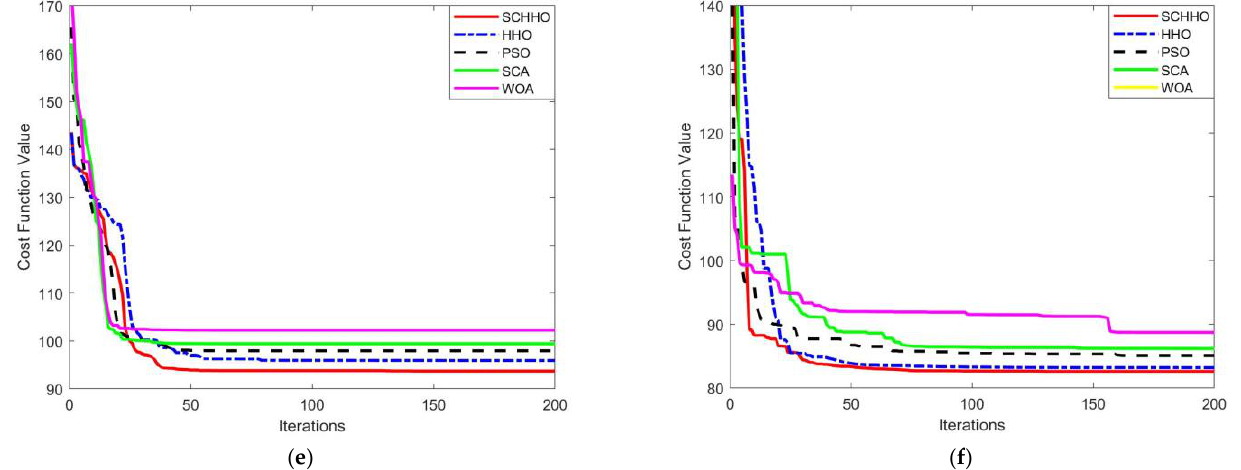
Figure A2. Convergence curves of five algorithms on six benchmark functions when n = 50. ( a ) Sphere. ( b ) Schwefel1.2. ( c ) Rosenbrock. ( d ) Rastrigin. ( e ) Ackley. ( f ) Griewank.